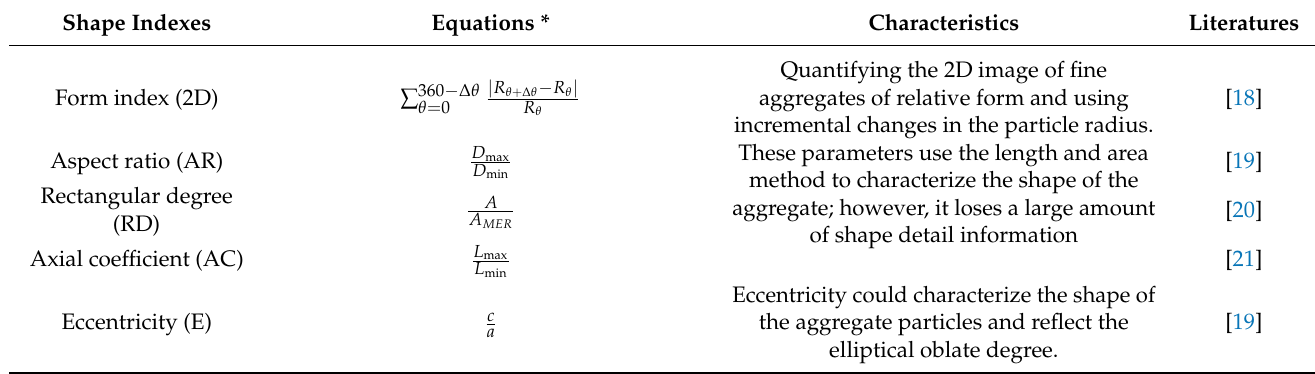
Table 1. Shape index of aggregate with calculation equations and main characteristics.